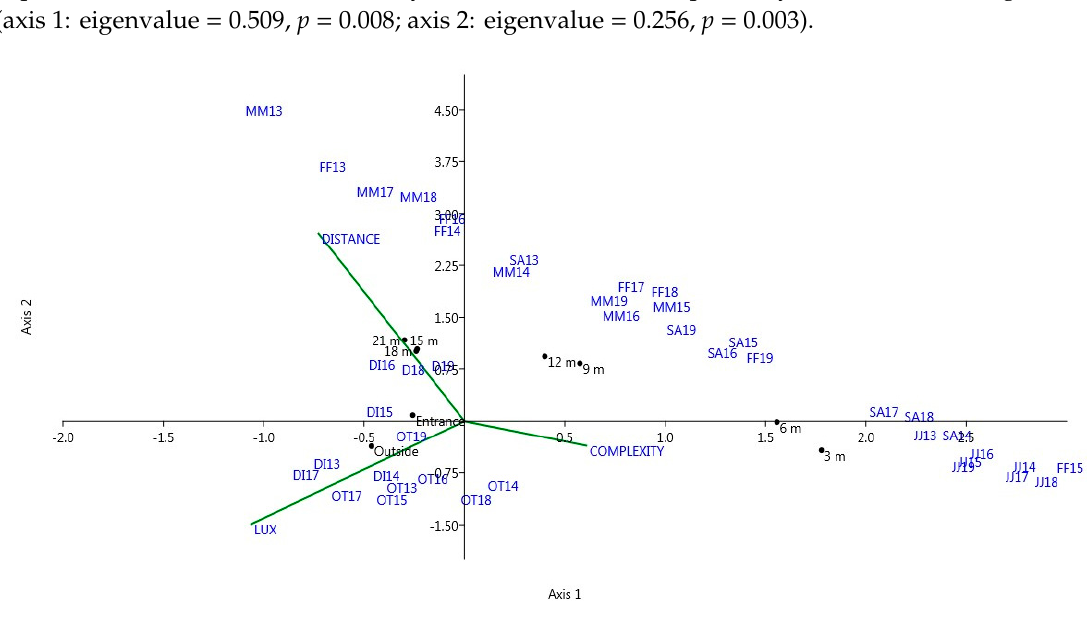
61 The CCA using the environmental variables and the entire biological community sampled along the subterranean gradient was highly significant (trace = 0.765; p = 0.001; Figure 2). The first two axes explained the entire variance of the system (67% and 33%, respectively), and both were significant